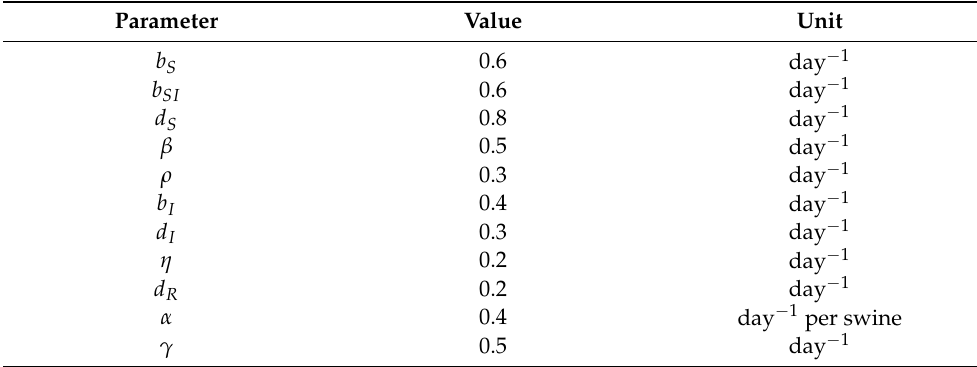
Figure 1. Plot of the phase portrait, in the Table 2. List of parametric values for PRRSV model system